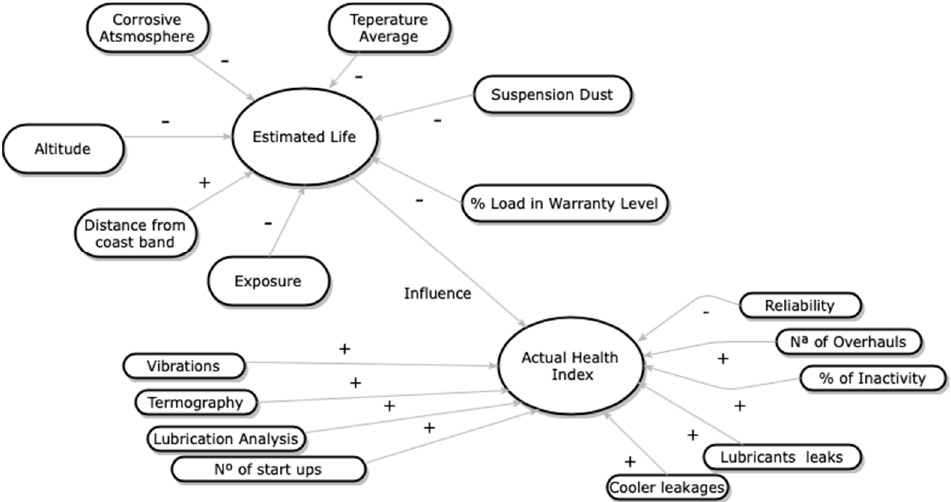
Figure 1. Asset Health Index, influence diagram.